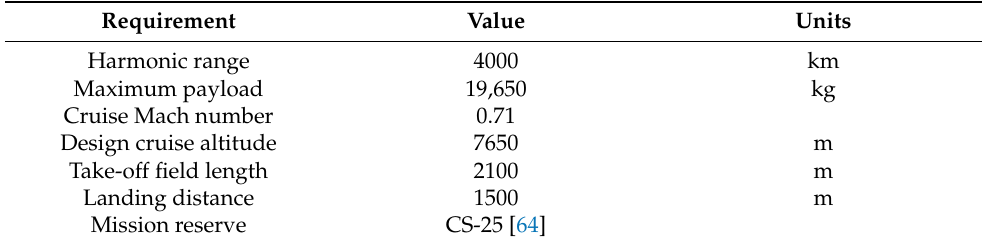
Table 3. SE 2 A MR top-level